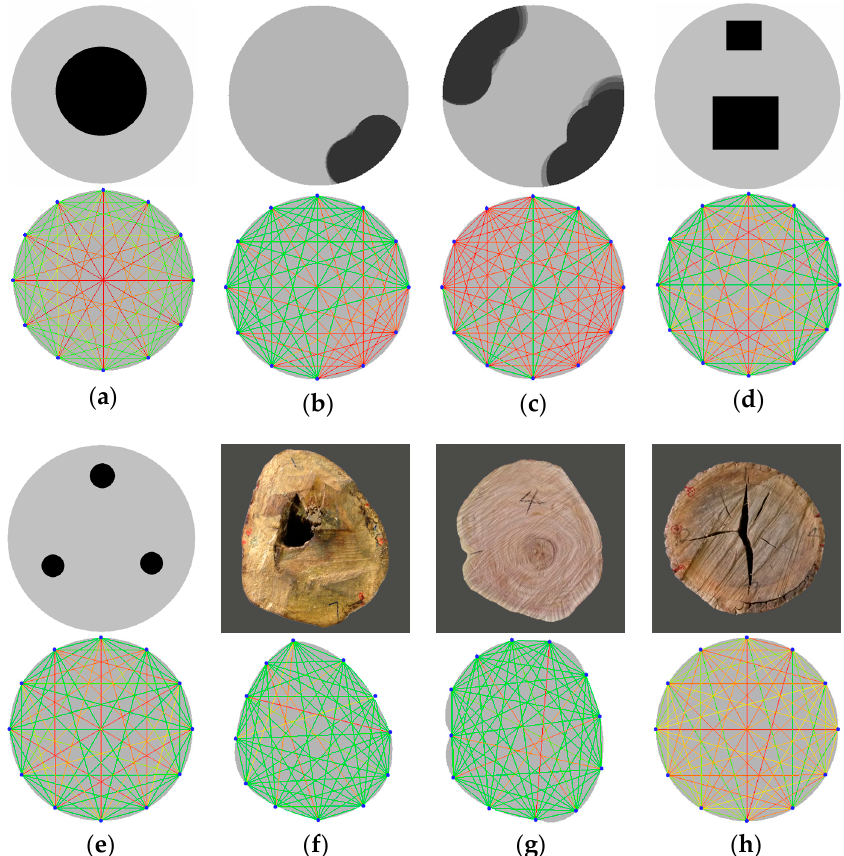
Figure 4. Simulation data (graph of defect distribution and graph of rays) and experimental data (real image of sample and graph of rays): ( a ) Single circle distribution; ( b ) single edge distribution; ( c ) two-edge distribution; ( d ) two-rectangle distribution; ( e ) three-circle distribution; ( f ) firmiana timber with hole defects; ( g ) chinaberry timber with knot defects; ( h ) pecan timber with crack defects.